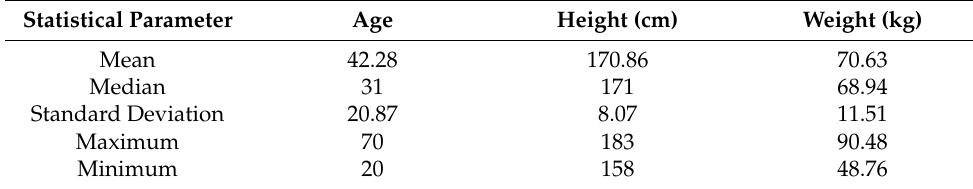
Table 1. Summary of participants’ information.